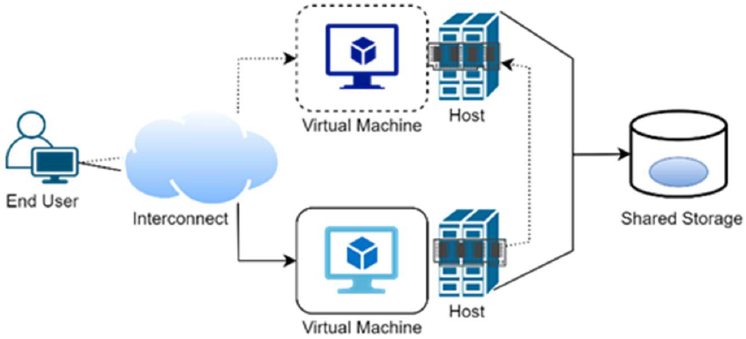
Figure 2. Live VM Migration.